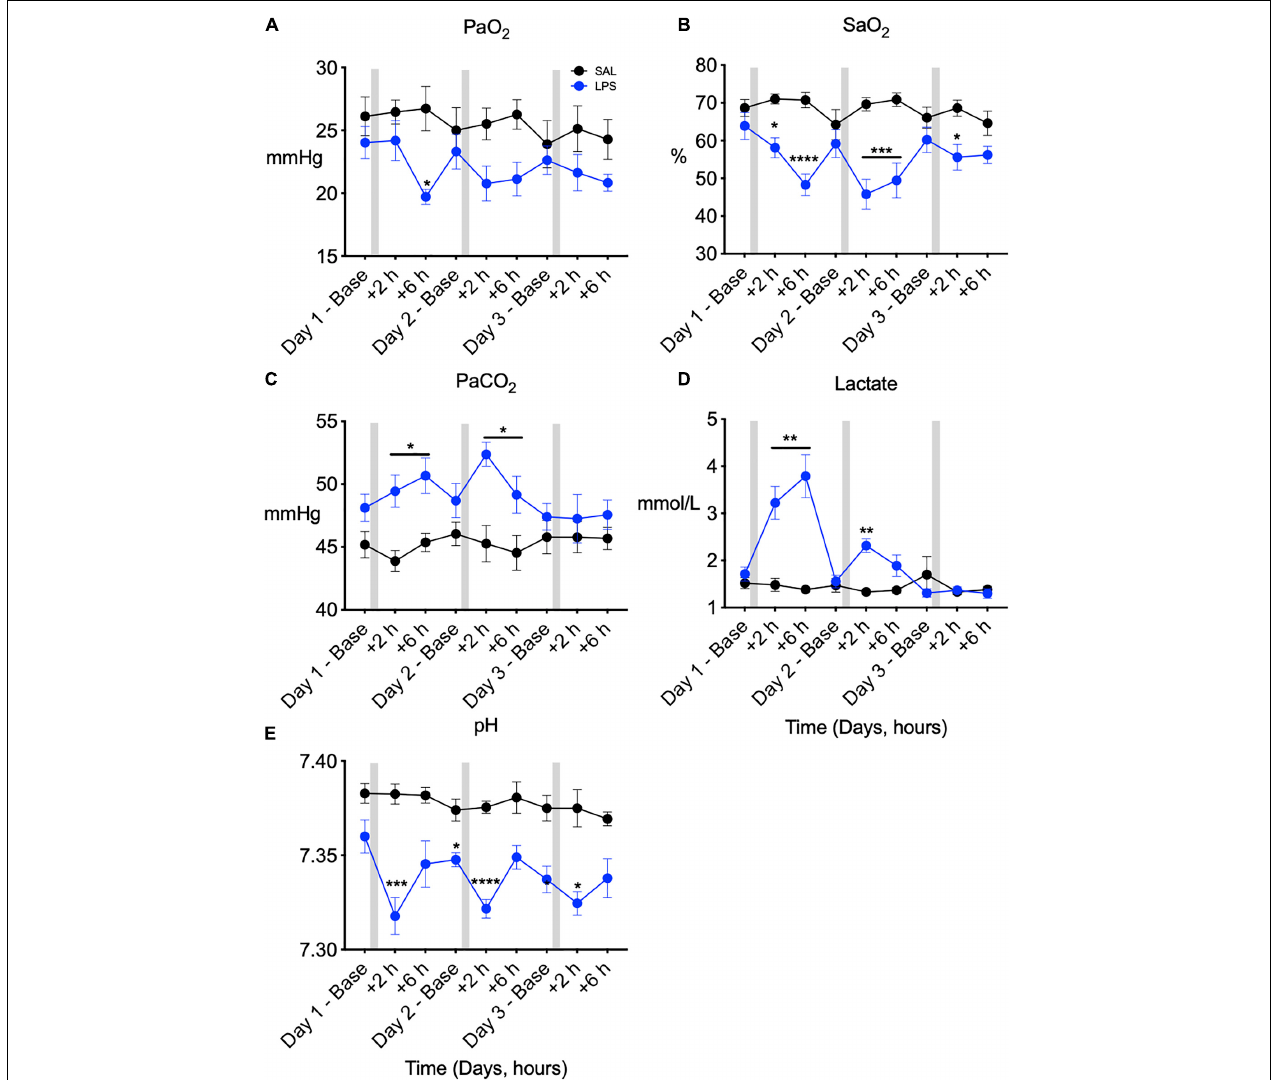
FIGURE 1 | Fetal arterial blood gases measured across 3 days at baseline (0 h), + 2 h, and + 6 h following saline [SAL (control)]/LPS infusions. Partial pressure of oxygen (PaO 2 , A ), oxygen saturation (SaO 2 , B ), partial pressure of carbon dioxide (PaCO 2 , C ), lactate (D) , and pH (E) in SAL (control = black) and LPS-exposed (blue) fetuses. Gray bars indicate SAL or LPS infusion on each day after baseline sampling. Data are means ± SEM, * P < 0.05 vs. control, ** P < 0.01 vs. control, *** P < 0.001 vs. control, **** P < 0.0001 vs. control.